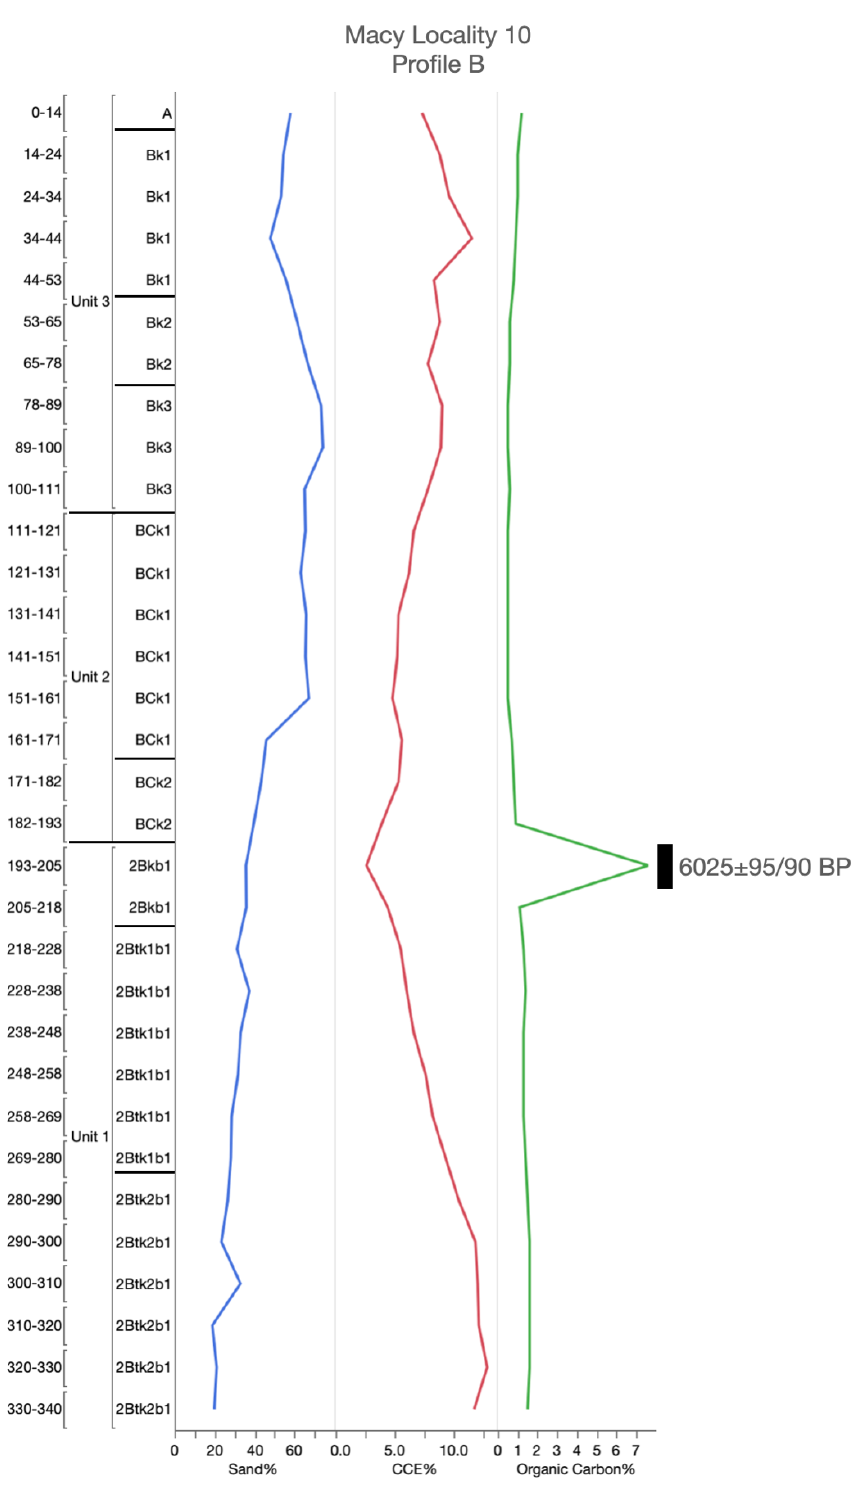
Figure A4. Accepted radiocarbon ages and soil and sediment analysis at Macy Locality 10, Profile B—Post research area, northwest, Texas. CCE = calcium carbonate equivalence.